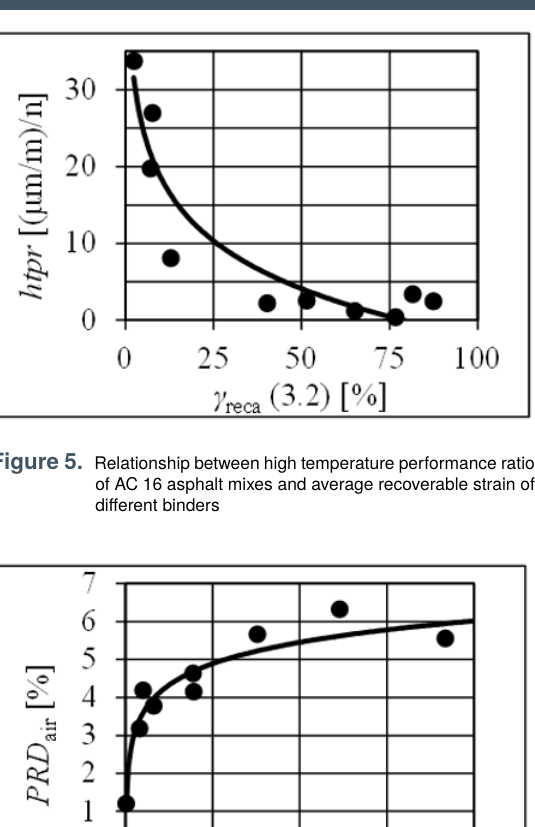
tracking tests. Correlation coefficients are 0.8726 and